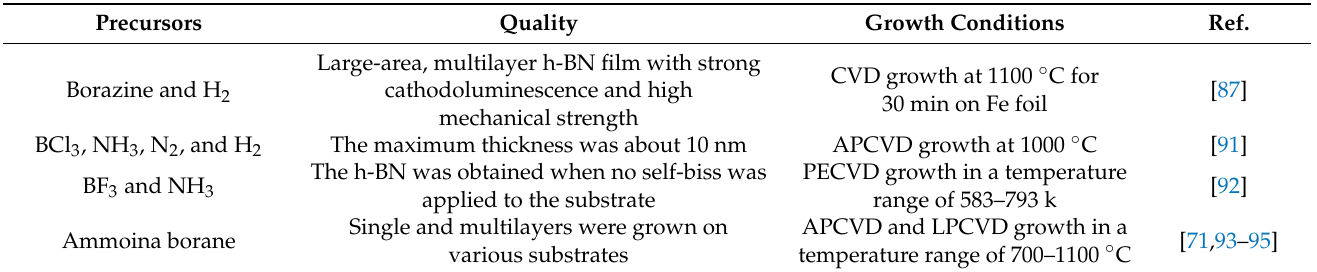
Table 5. This table summarizes the precursors, growth conditions, and quality of CVD-grown h-